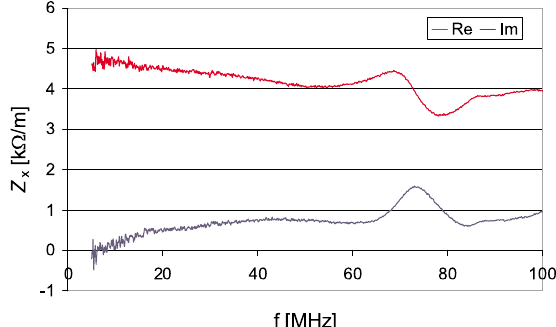
FIG. 21. (Color) Horizontal impedance of the kicker